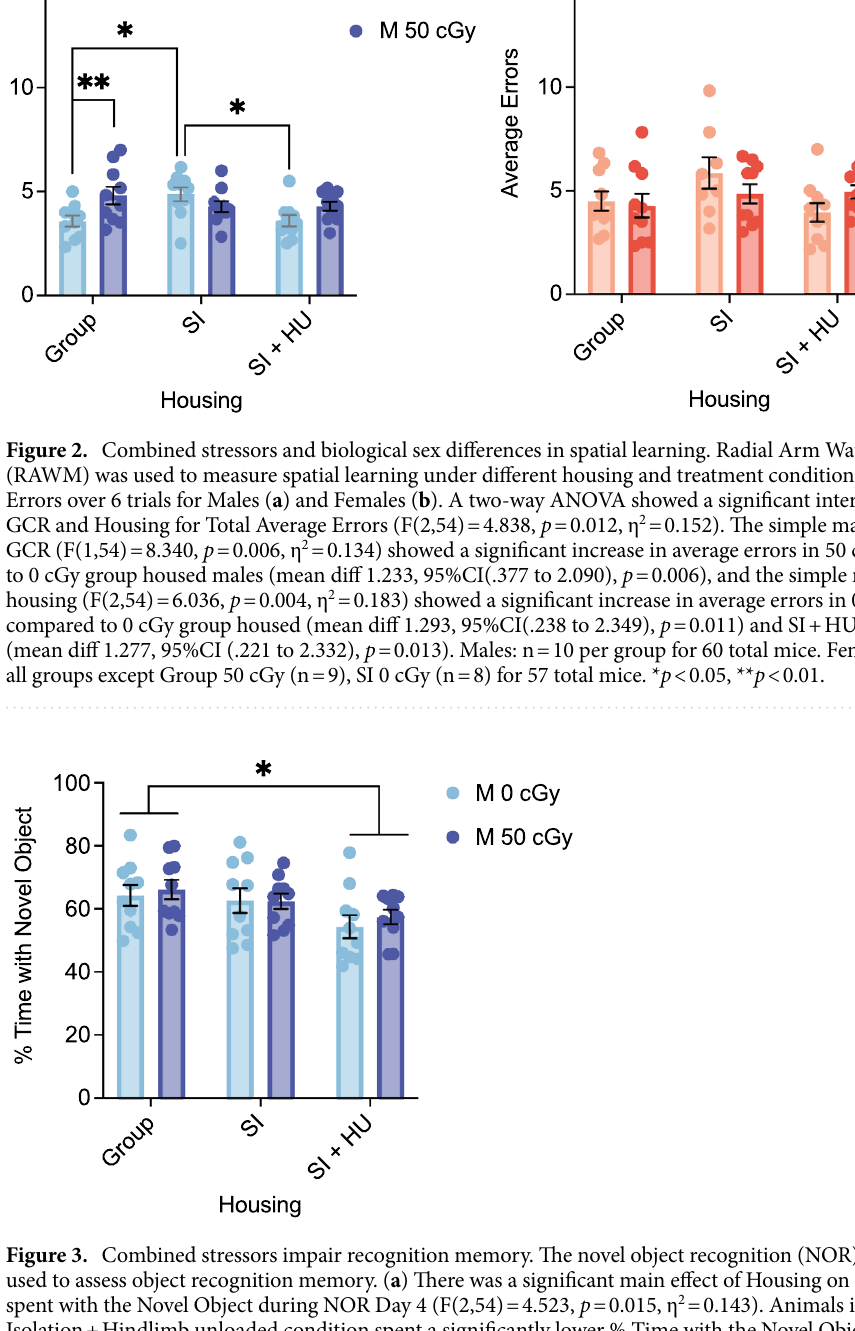
mouse (Fig. 4c) and total time (s) spent with the familiar and novel mice (Fig. 4d), regardless of housing con- dition. However, the percentage of time spent with the novel mouse out of total time with both the novel and familiar mice was not affected by GCRsim or housing condition. Experimental mice adequately distinguished the novel and familiar mice, demonstrating social memory itself was not affected by the stressors (Supplementary Fig. S3a,b). The differences in raw time, but not normalized percentage, suggest differences in social exploration behavior, rather than social memory.